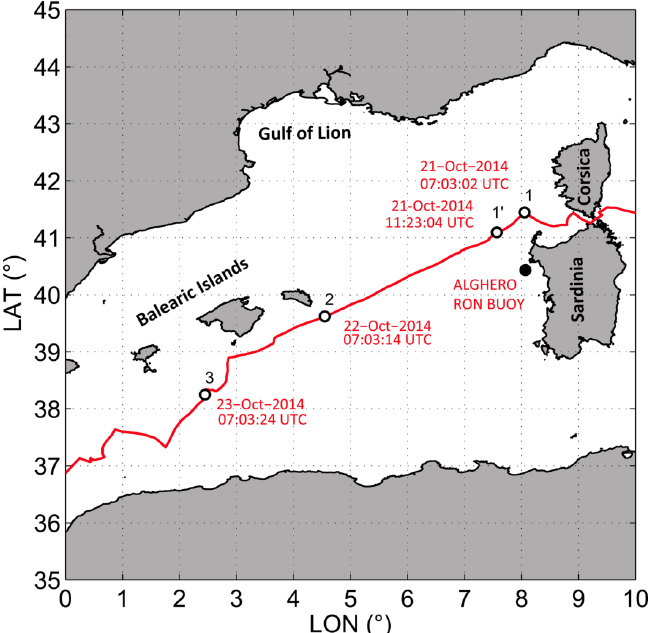
Figure 2. The route in the western Mediterranean Sea followed by ECO40. The empty dots refer to four points of interest along the route and the black dot identifies the position of the Alghero wave